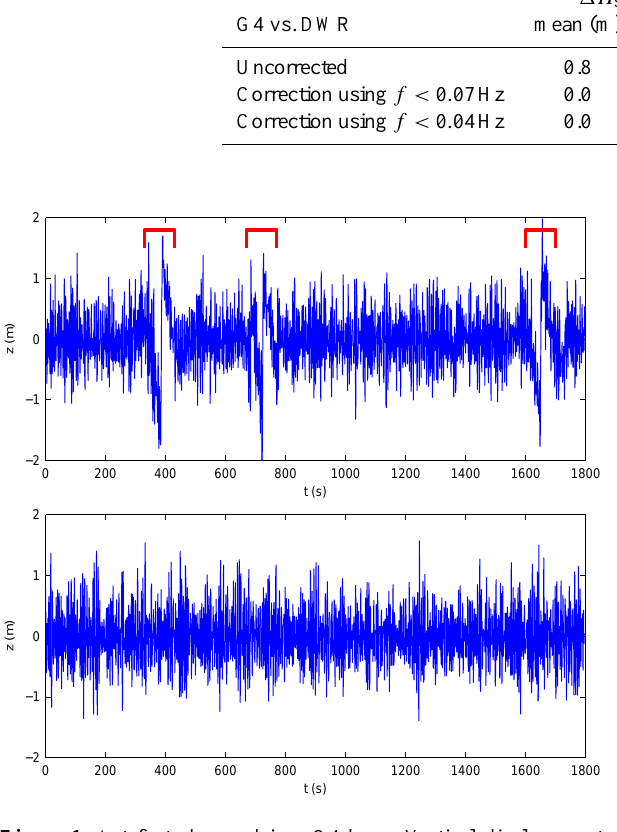
Figure 1. Artefact observed in a G4 buoy. Vertical displacement measured with the G4 buoy with the artificial jumps indicated with red arrows (top panel). Vertical-displacement time series of the mea- surements by an accelerometer-based DWR made in close proxim- ity and during roughly the same time (bottom panel). The distance between the two devices were about 900m.